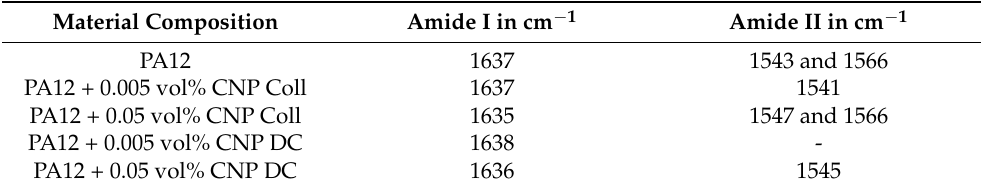
Table 4. Positions of the amide I and amide II bands in PA12/CNP composite specimens.